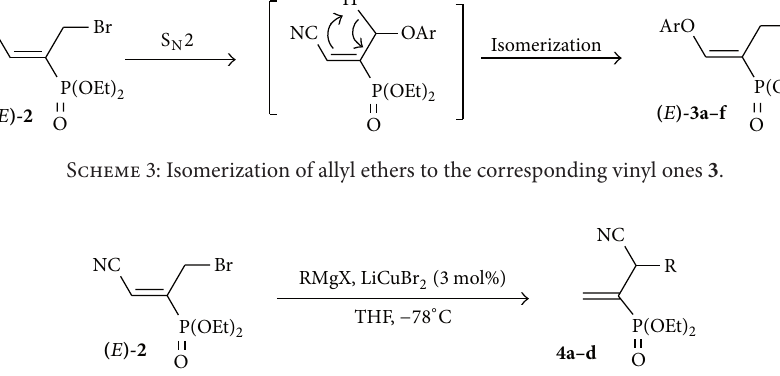
IsomerizationNC Br